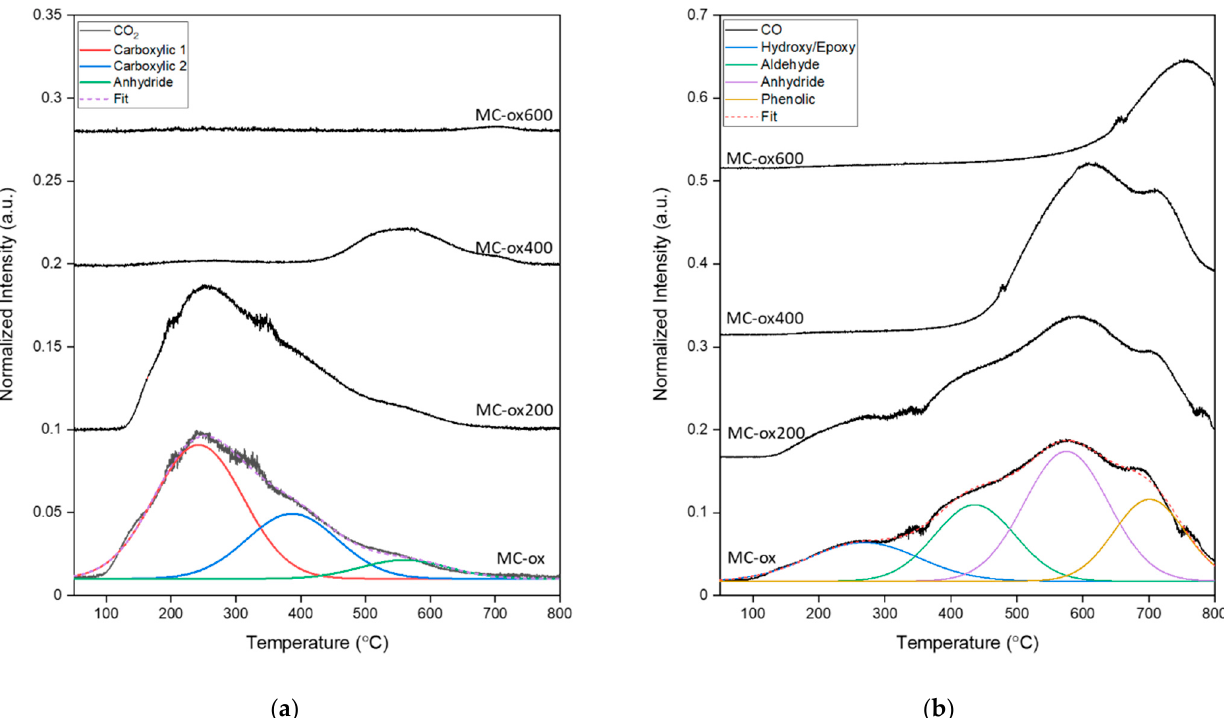
Figure 7. TPD-MS analysis of functionalized MC samples: ( a ) CO 2 profile (carboxylic acid: red and blue, anhydride: green); ( b ) CO profile (blue: hydroxyl/epoxy, green: aldehyde, purple: anhydride, golden: phenol).